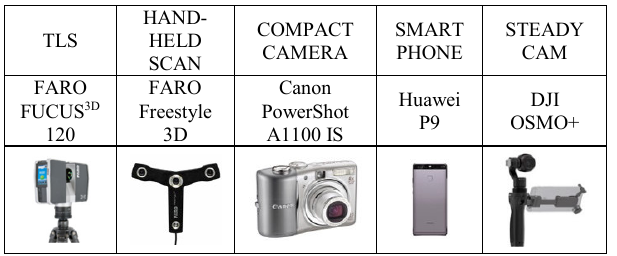
Table 1. The employed sensors